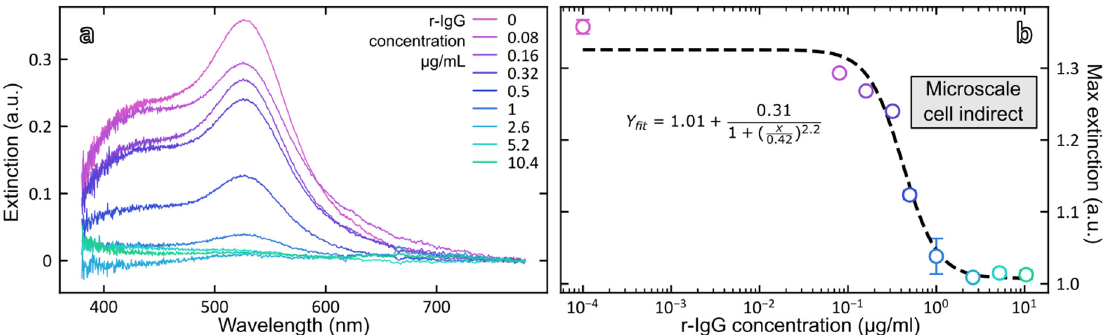
Figure 7. ( a ) Extinction spectra of the unbound fraction of AuNP-Ab after incubation of rabbit IgG in the range 0–10.4 µg/mL measured in the microcell; ( b ) Dose–response curve plotted from the maximum extinction at 530 nm vs. rabbit IgG concentration.